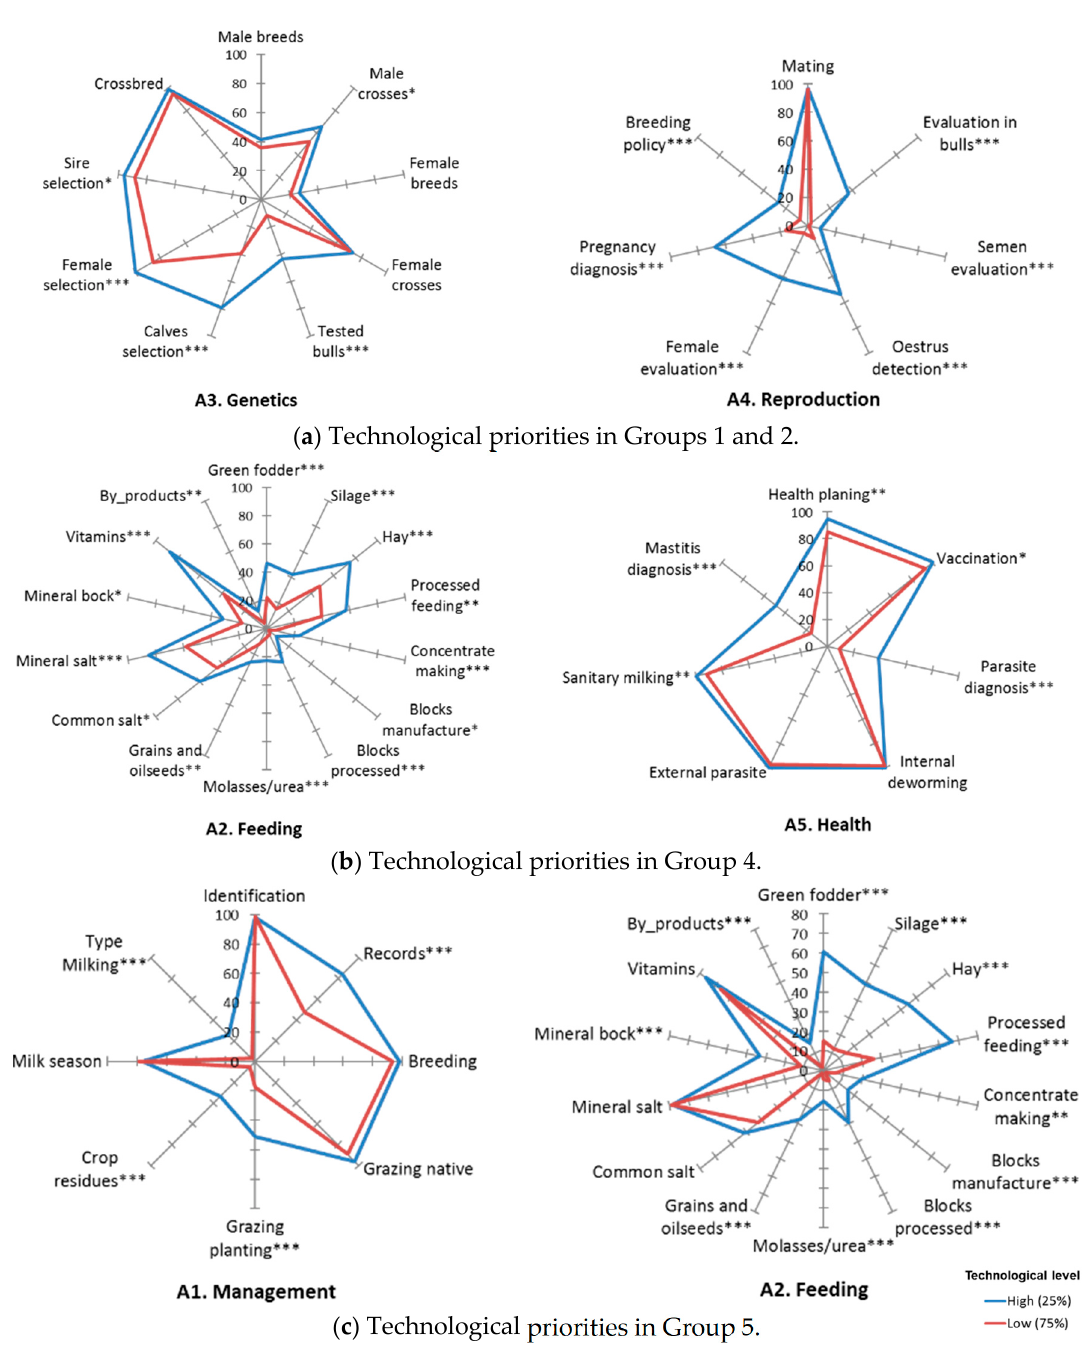
Figure 2. Technological priorities in each group of smallholder dual-purpose farms. *** Significant differences between farms with high (25%) and low (75%) technological level (* p < 0.05, ** p < 0.01, *** p < 0.001).